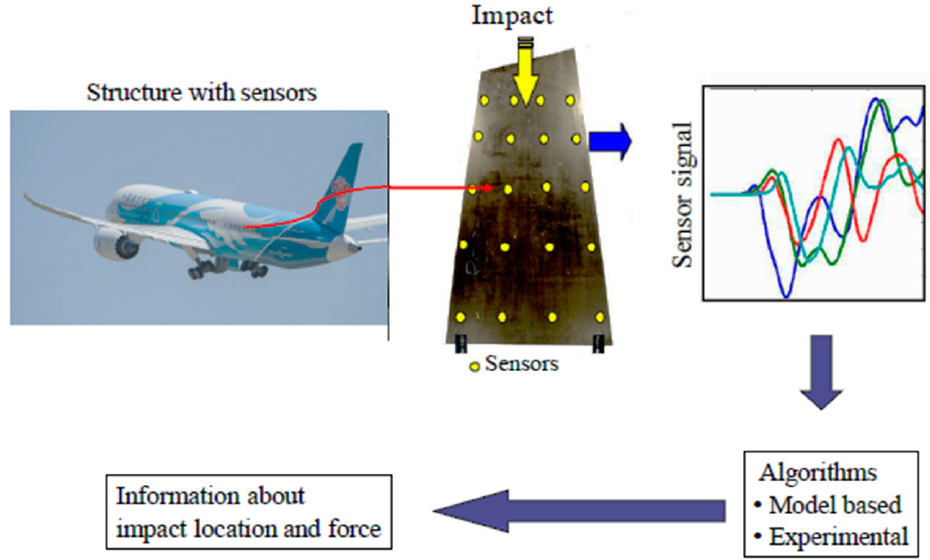
Figure 7. Impact monitoring of aircraft structures [120]. Reprinted under the Creative Commons (CC) License (CC BY 4.0).